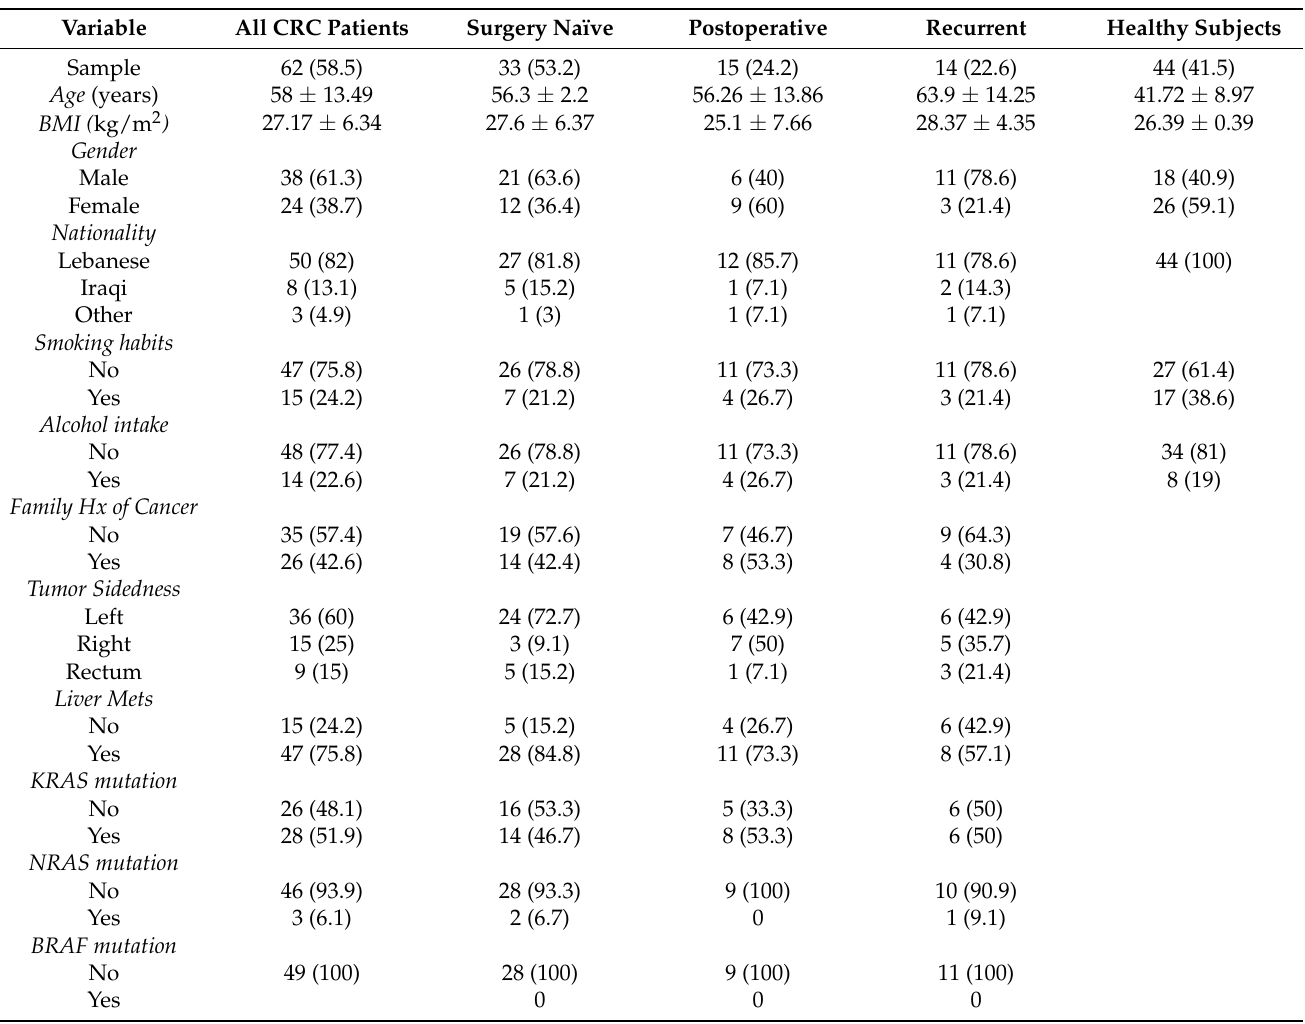
Table 1. Distribution of Clinicopathological Data for Stage IV CRC patients and healthy subjects. Data were presented